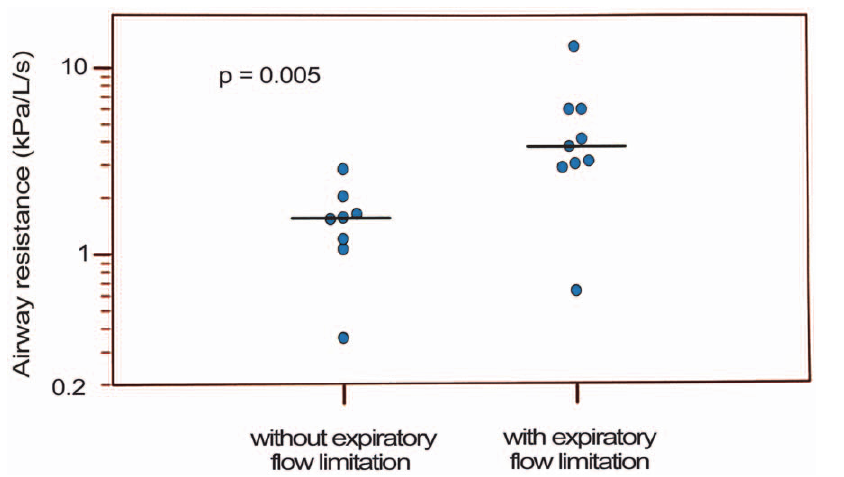
Figure 2. Expiratory flow limitation of the TBFVL and its impact on airway resistance (R aw is presented on a logarithmical scale and the horizontal bar represents the median).